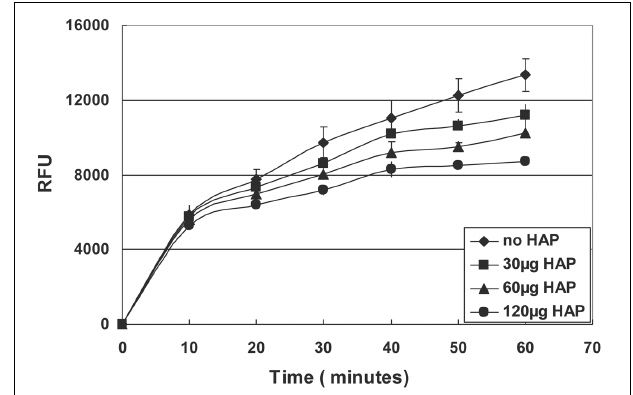
FIGURE 5 | Hydrolysis of quenched peptide by MMP20 in the presence of different amount of HAP.